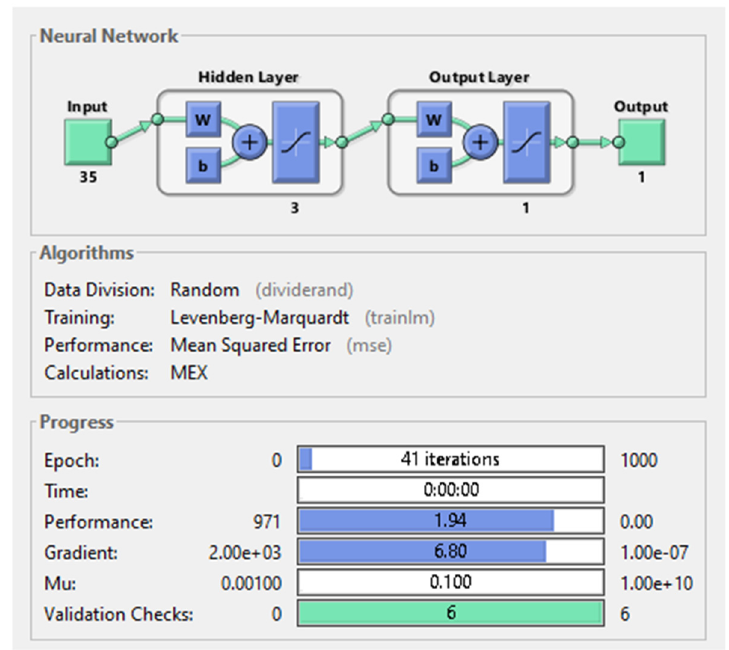
Figure 7. Shallow neural network with 1 hidden-layer and 3 neurons on it.